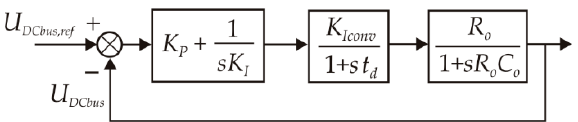
Figure 12. Block diagram of the DC-DC converter closed loop control system.